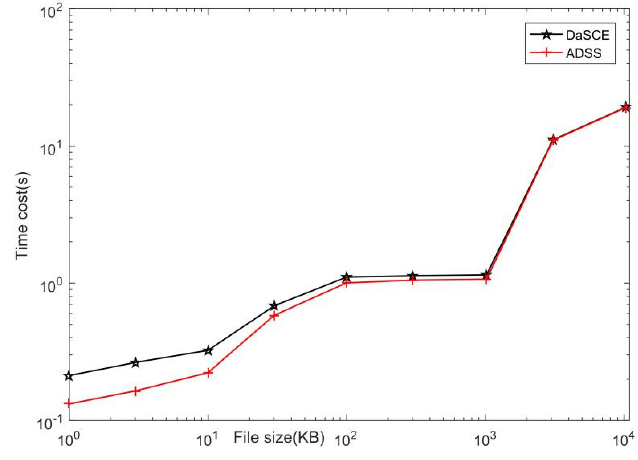
Figure 10. Comparison of file upload times in two protocols.